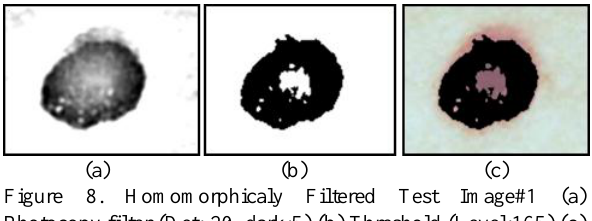
Figure 8. Homomorphicaly Filtered Test Image#1 (a) Photocopy filter (Det: 20, dark:5) (b) Threshold (Level:165) (c) overlay with original image